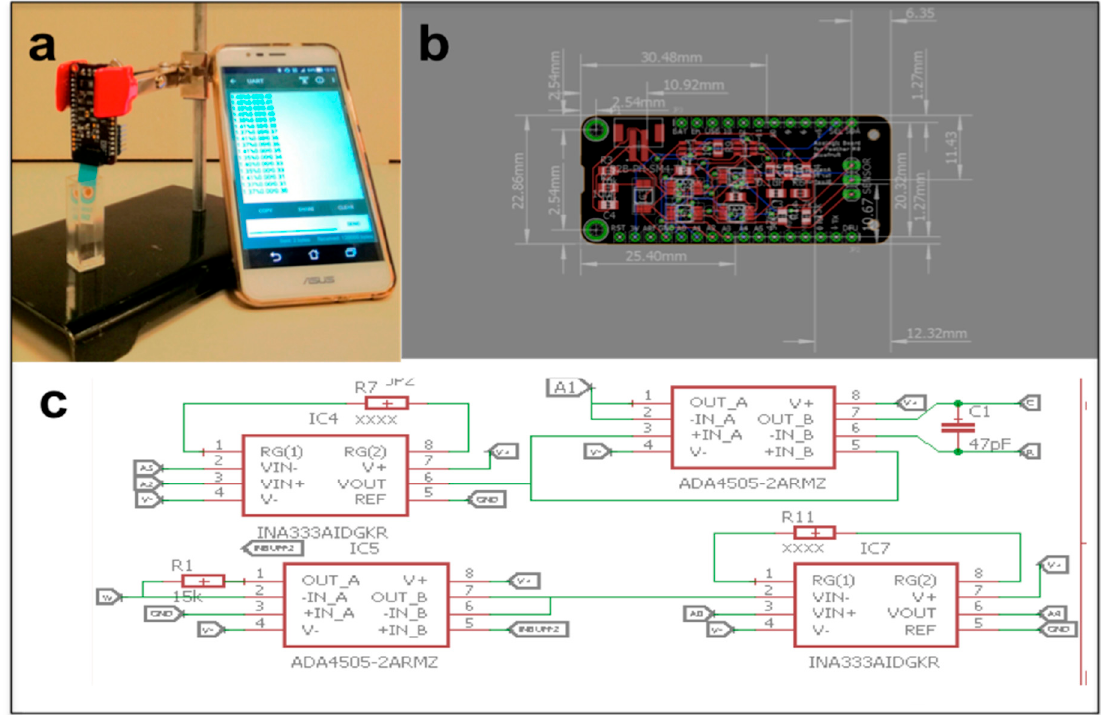
Figure 1. Developed sensor system analysing a liquid sample and transmitting data to a smartphone using a BLE connection: ( a ) experimental set-up using a smartphone; ( b ) layout of the electronic interface; ( c ) schematic of the electronic interface between the sensor and the